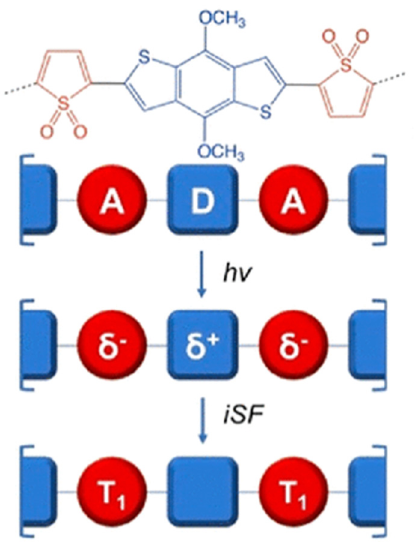
Figure 6. The process of iSF in donor–acceptor copolymers. Reproduced with a permission from [75], copyright 2020 American Chemical Society.